Question: Give a one-sentence summary of this figure.
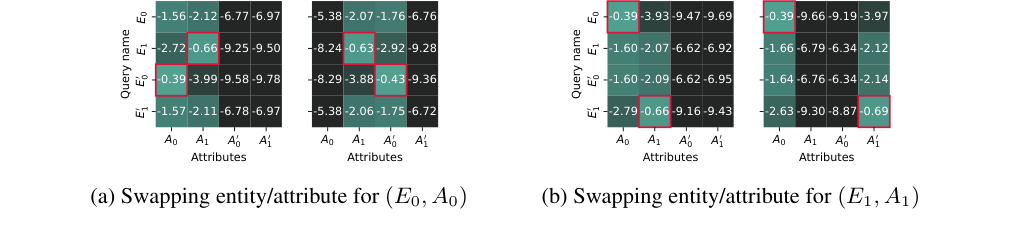
Answer: Factorizability results. Each row corresponds to querying for a particular entity. Plotted are the mean log prob for all four attributes. Highlighted squares are predicted by factorizability.